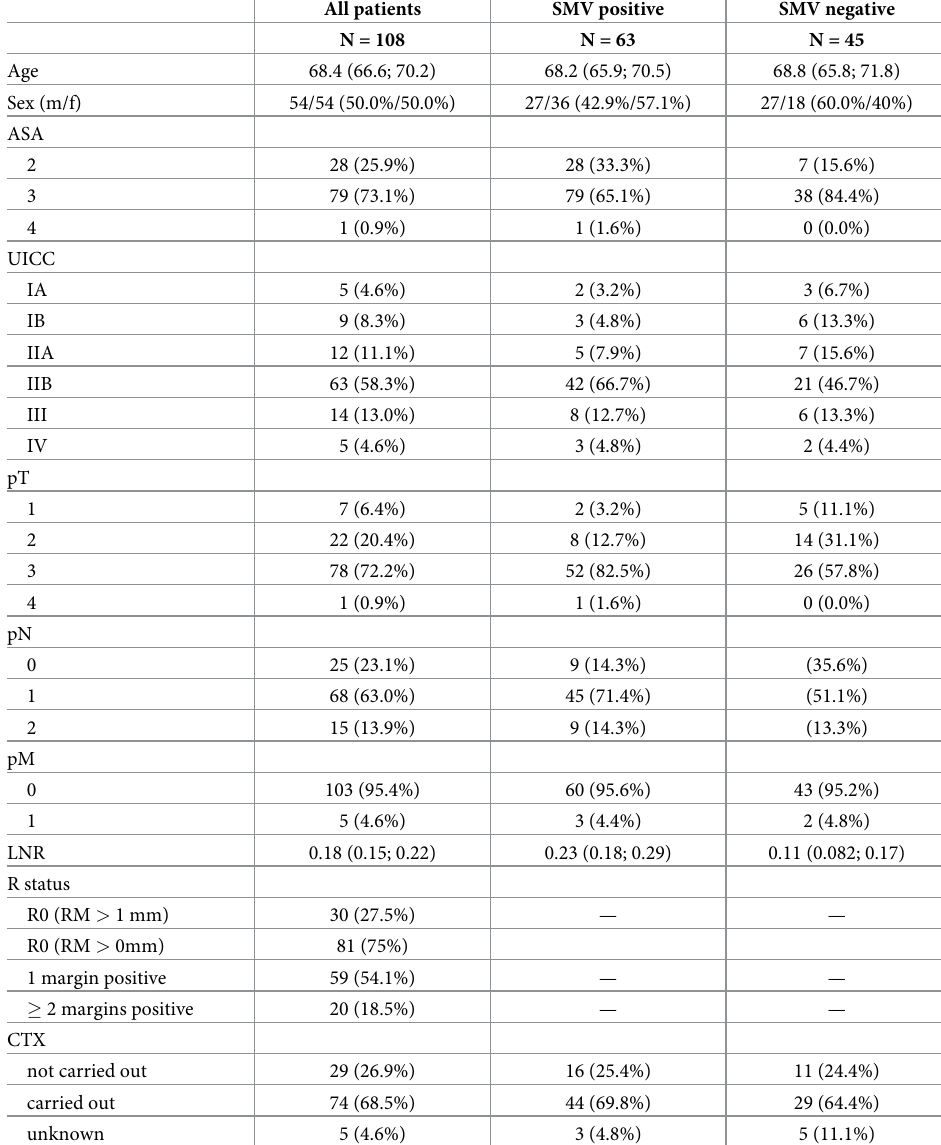
Table 1. Patient characteristics: Given are the mean and 95%CI, or the number and percentage, respectively. All patients SMV positive SMV negative